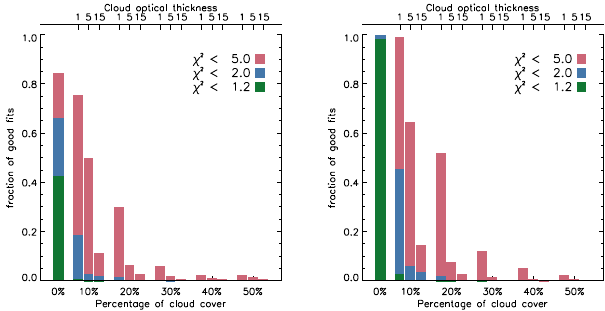
Figure 2. The fraction of good retrievals for three different χ 2 fil- ters, per cloud fraction bin, for the normal (left) and perfect first guess retrieval (right). The cloud fraction bins have been further di- vided into the three optical thicknesses (top axis) that were used to simulate the